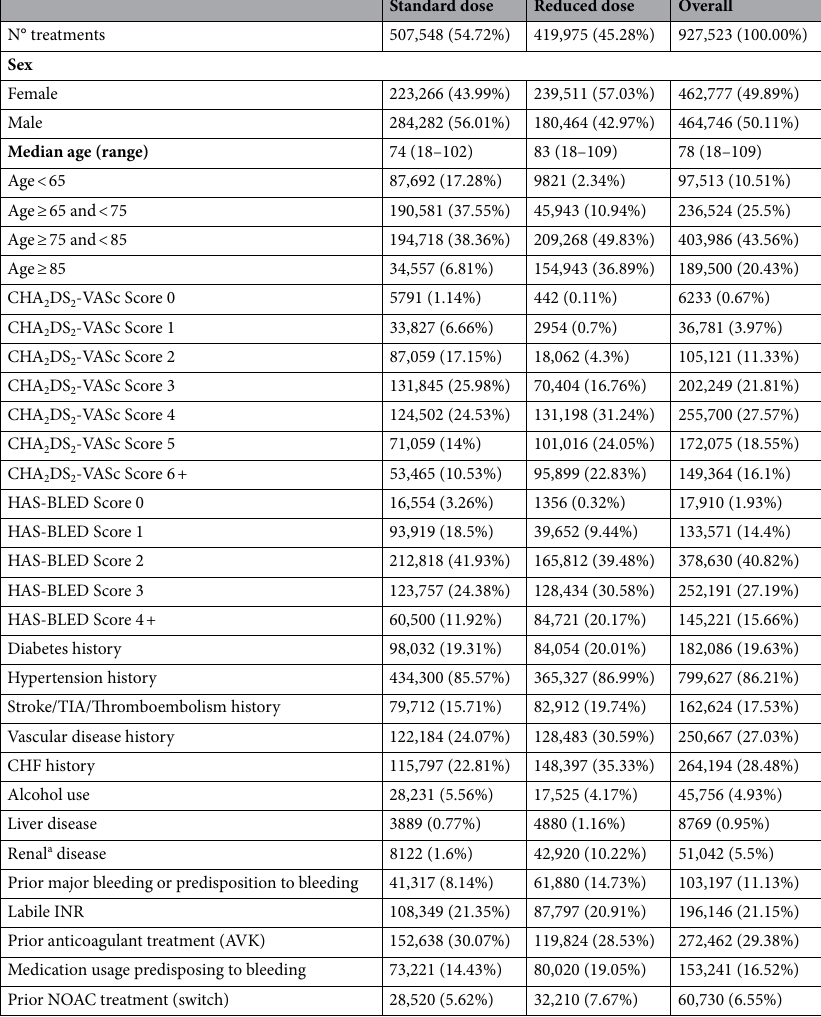
Table 1. Baseline characteristics of the population according divided according to dose of NOACs at first prescription in AIFA Registry. Data are expressed as mean and min–max range or numbers and percentages. a Renal disease = renal transplantation or dialysis or plasma creatinin > 200